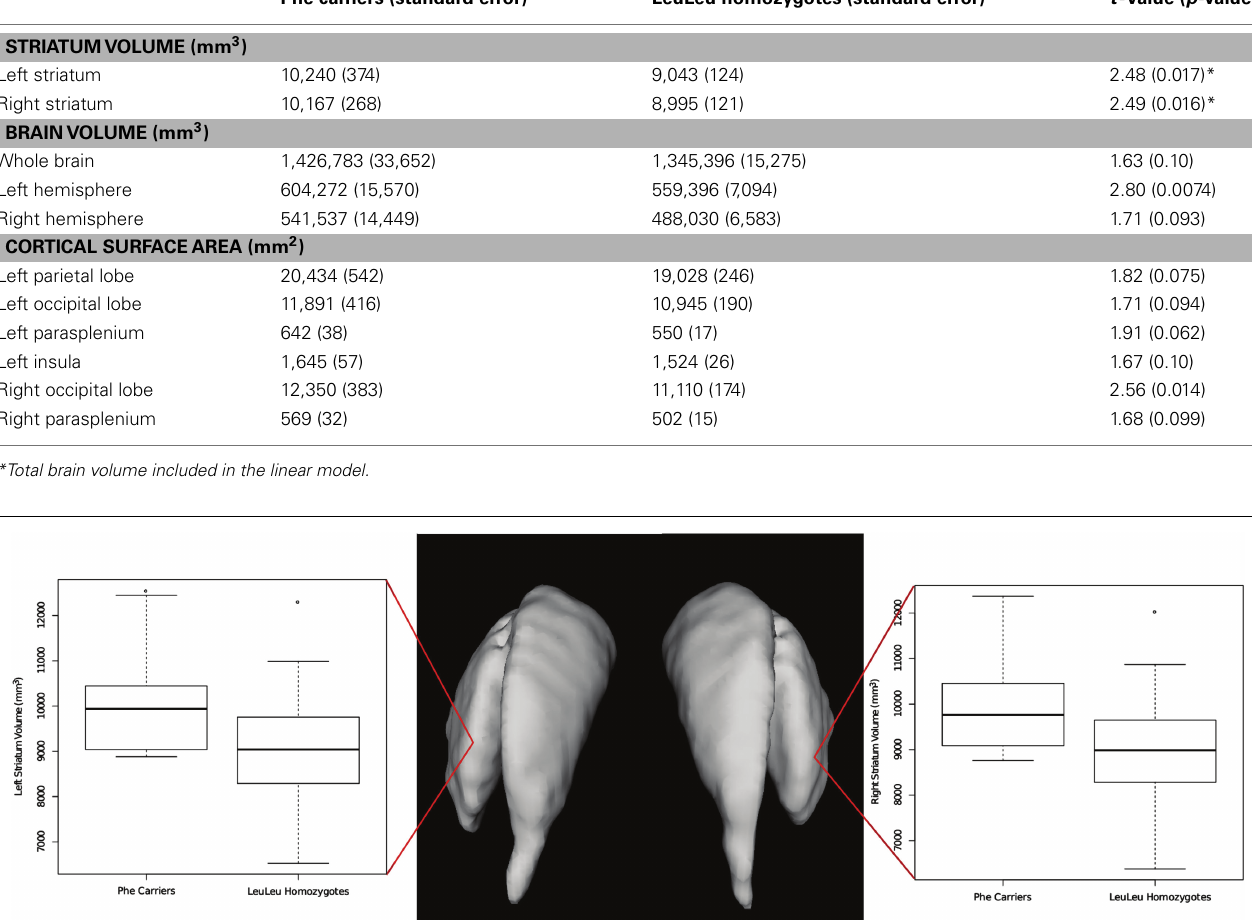
Table 2 | Results from the volumetric analysis, cortical thickness, and surface area for Leu607Phe genotypes. Phe carriers (standard error) LeuLeu homozygotes (standard error) t -Value ( p -value)